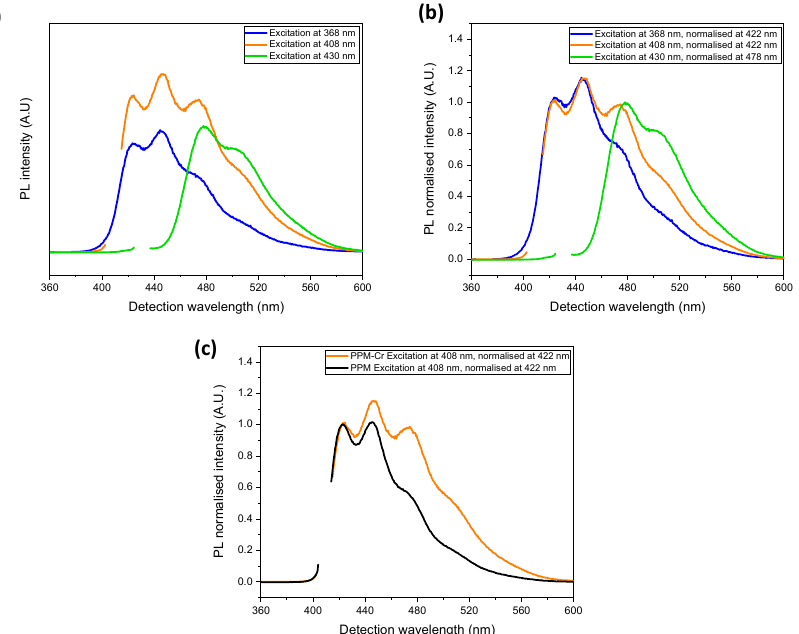
Figure 10. PL spectra (50 mg/mL) in chloroform, ( a ) PPM-Cr(CO) 3 (0.055 Cr per phenylene group), excitation at 368 nm (blue curve), 408 nm (orange curve) and 430 nm (green curve); ( b ) normalized spectra related to ( a ); ( c ) normalized spectra with excitation at 408 nm of PPM (black curve) and PPM-Cr(CO) 3 (orange curve).